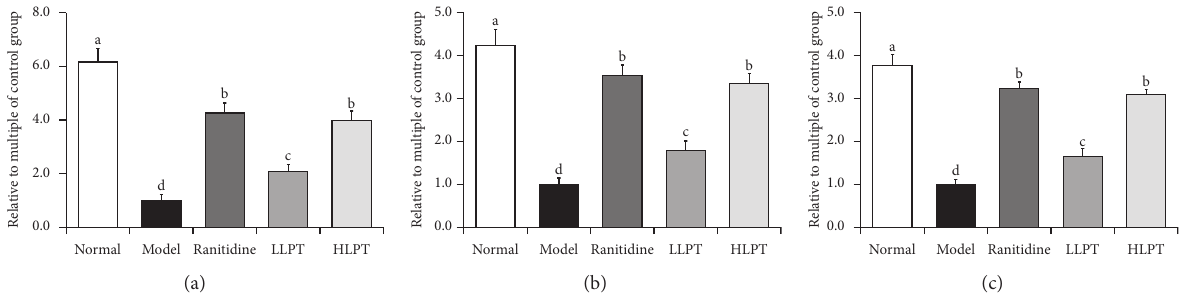
Figure 4: The mRNA expression level of (a) Cu/Zn-SOD, (b) Mn-SOD, and (c) CAT in the gastric tissue of mice. Values presented are the mean ± standard deviation. a–c Mean values with different letters in the bar are significantly different ( p < 0 . 05) according to Duncan’s new MRT. Ranitidine group: 50mg/kg b.w. ranitidine treatment dose; LLTP group: 100mg/kg b.w. Liupao tea polyphenols dose; and HLTP group: 200mg/kg b.w. Liupao tea polyphenols dose.